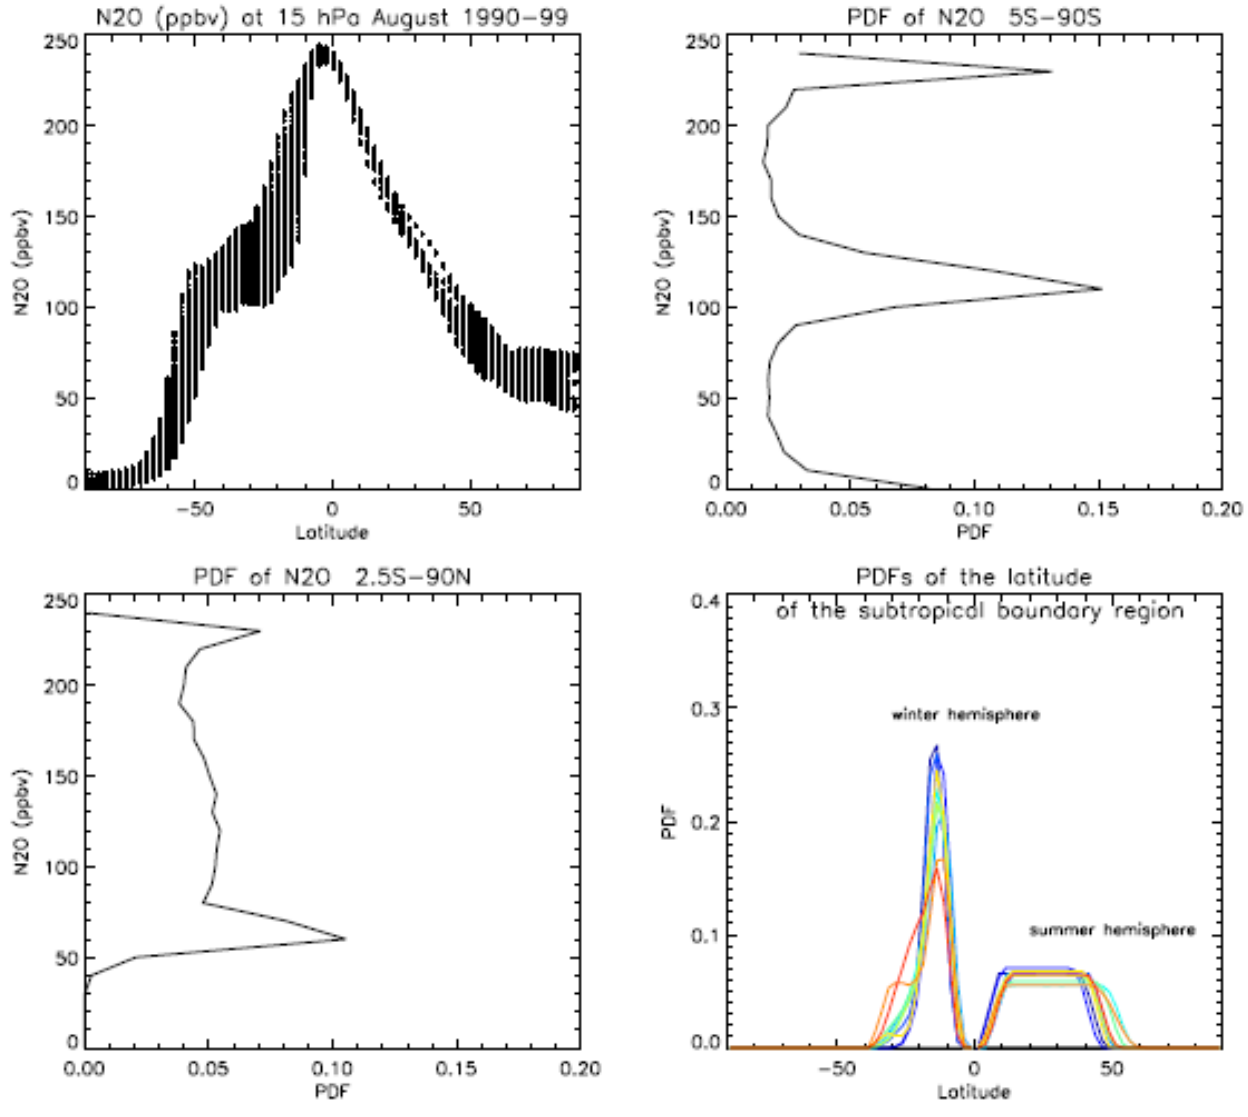
Fig. 7. Latitudinal distribution of the simulated N 2 O mixing ratios at 15hPa in August for 1990–1999 (top left). Area weighted PDF of the N2O mixing ratios for the winter hemisphere (top right) and for the summer hemisphere (bottom left). PDF of the latitude of the subtropical boundary region (bottom right) for the winter and summer hemispheres for each year from 1990 (blue) to 1999 (red).